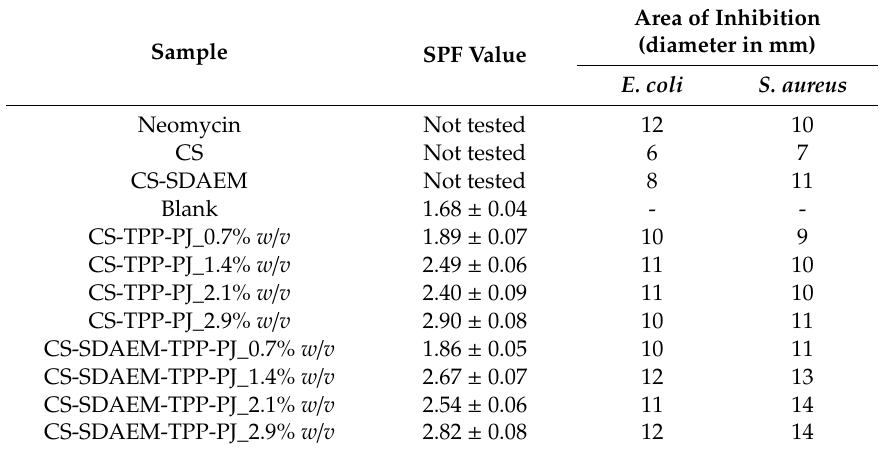
Table 6. Sun protection factor (SPF) values, standard deviation (STD) and Antibacterial activity of the prepared emulsions and inhibition growth zones against E.coli and S.aureus